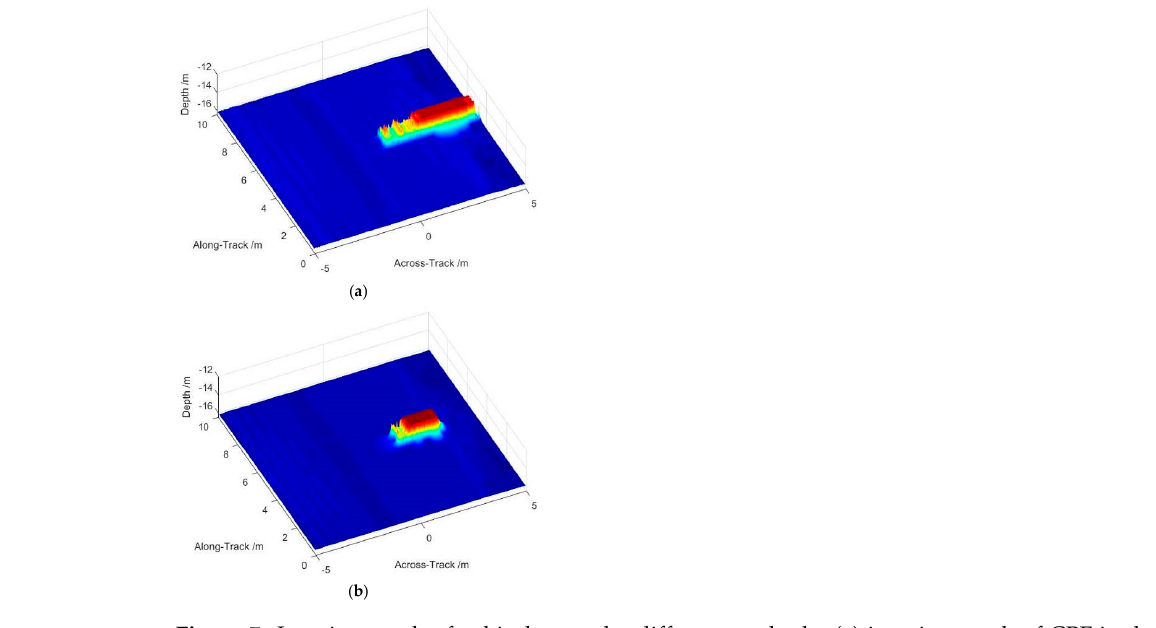
Figure 7. Imaging result of cubical target by different methods: ( a ) imaging result of CBF in the across-track direction; and ( b ) imaging result of accelerated deconvolved beamforming in the across-track direction.